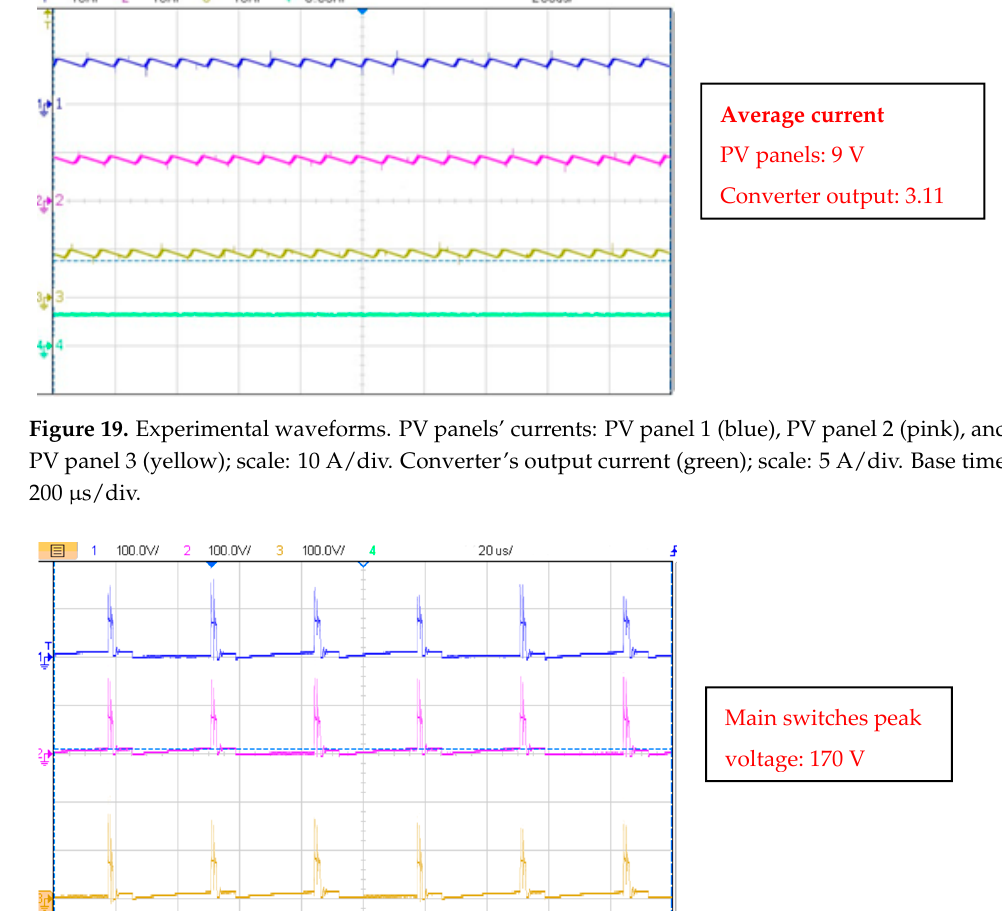
Figure 20. Experimental waveforms. Drain-source voltage: main switch 1 (blue), main switch 2 (pink), and main switch 3 (yellow); scale: 100 V/div. Base time 20 µs/div.